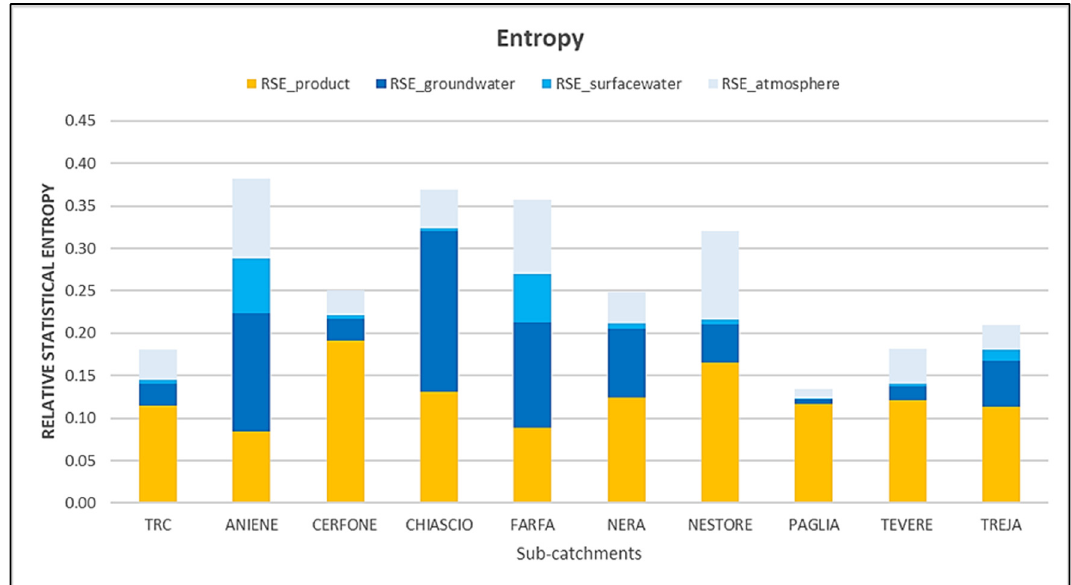
Figure 5. RSE output contributions for the TRC system and its sub-catchments. The RSE product represents nitrogen converted mainly into biomass (crop uptake, in our case). It corresponds to the system’s ability to concentrate the input nitrogen into the product. RSE_groundwater, RSE_surfac water and RSE_atmosphere indicate the loss of nitrogen by the system in the various environmental matrices. The total relative statistical entropy of each sub-basin and the whole TRC is given by the sum of the single components. A high system efficiency regarding the handling of nitrogen is indicated by low RSE values. Such values indicate that most of the nitrogen is converted into a product with minimal dispersion (“dilution”) in the environment.